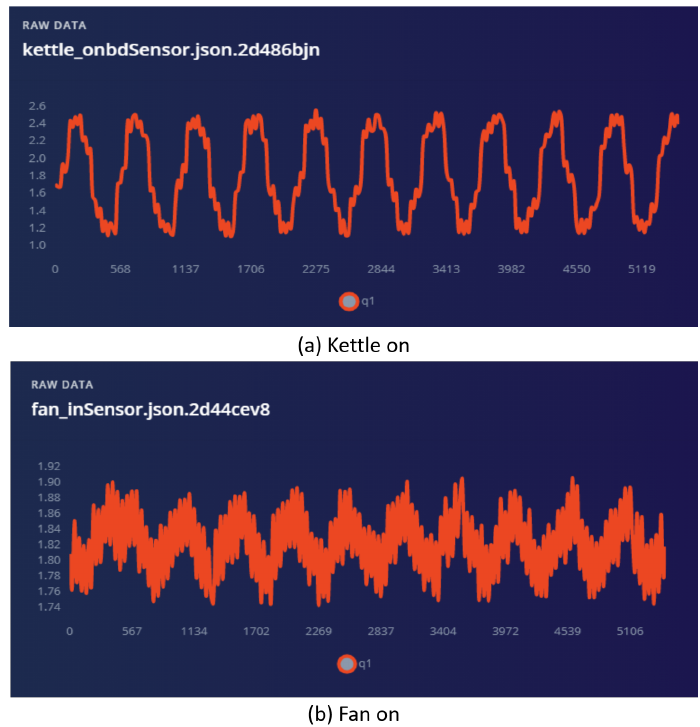
Figure 8. The current waveform of kettle on and fan on.